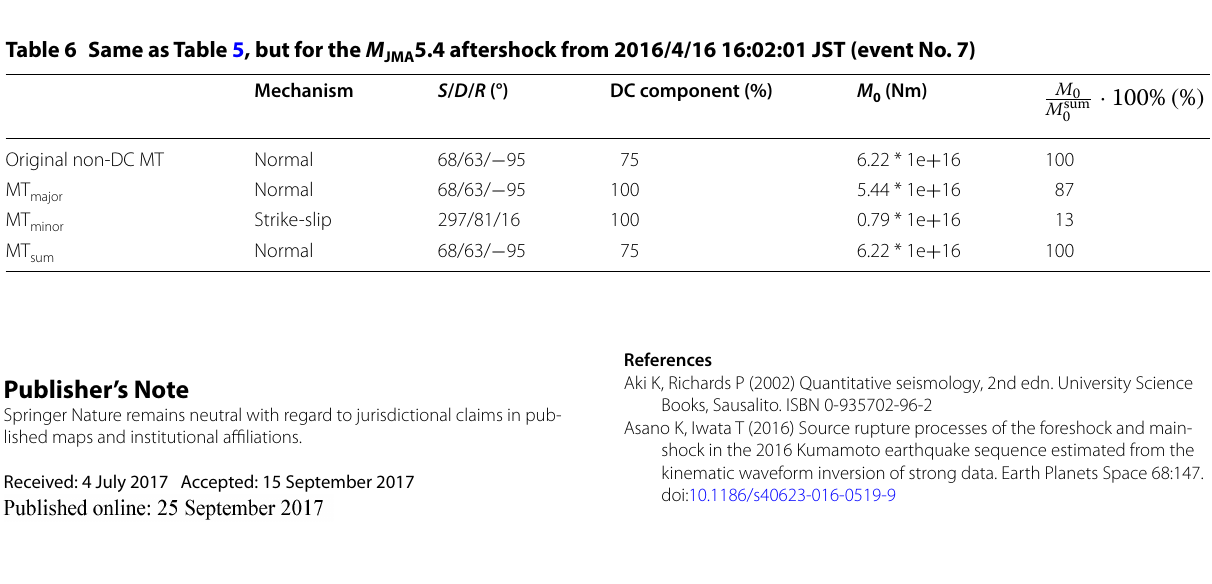
The original non-DC solution is listed with decomposed DC major and minor MTs and their sum MT major + MT minor = MT sum ; S / D / R strike/dip/rake